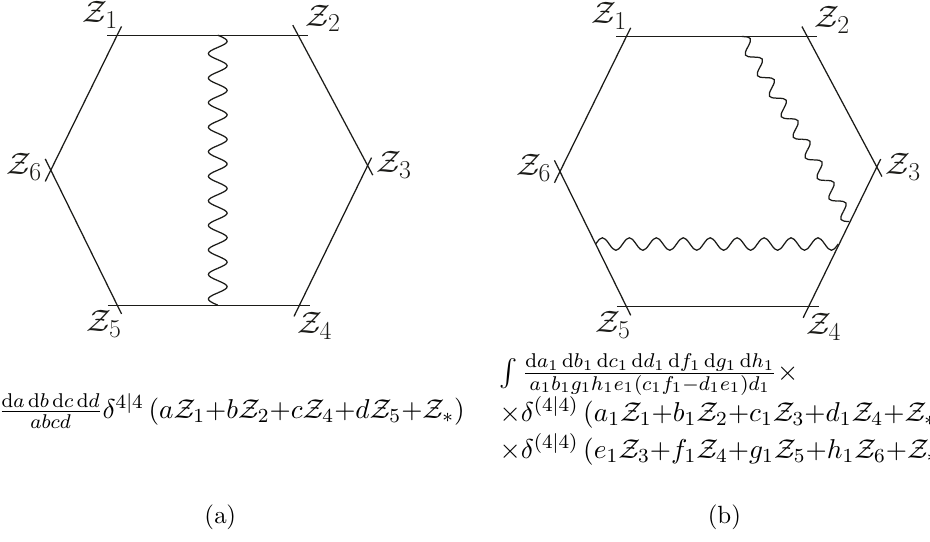
Figure 4 . Examples of Feynman diagrams in twistor space that contribute to the 6-point NMHV/N 2 MHV amplitude with their corresponding expressions following the rules